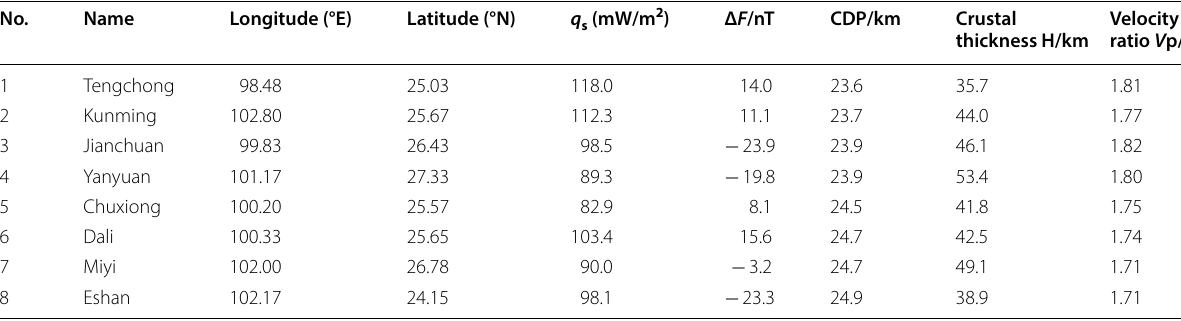
Table 1 Contrast terrestrial heat flow and magnetic anomalies